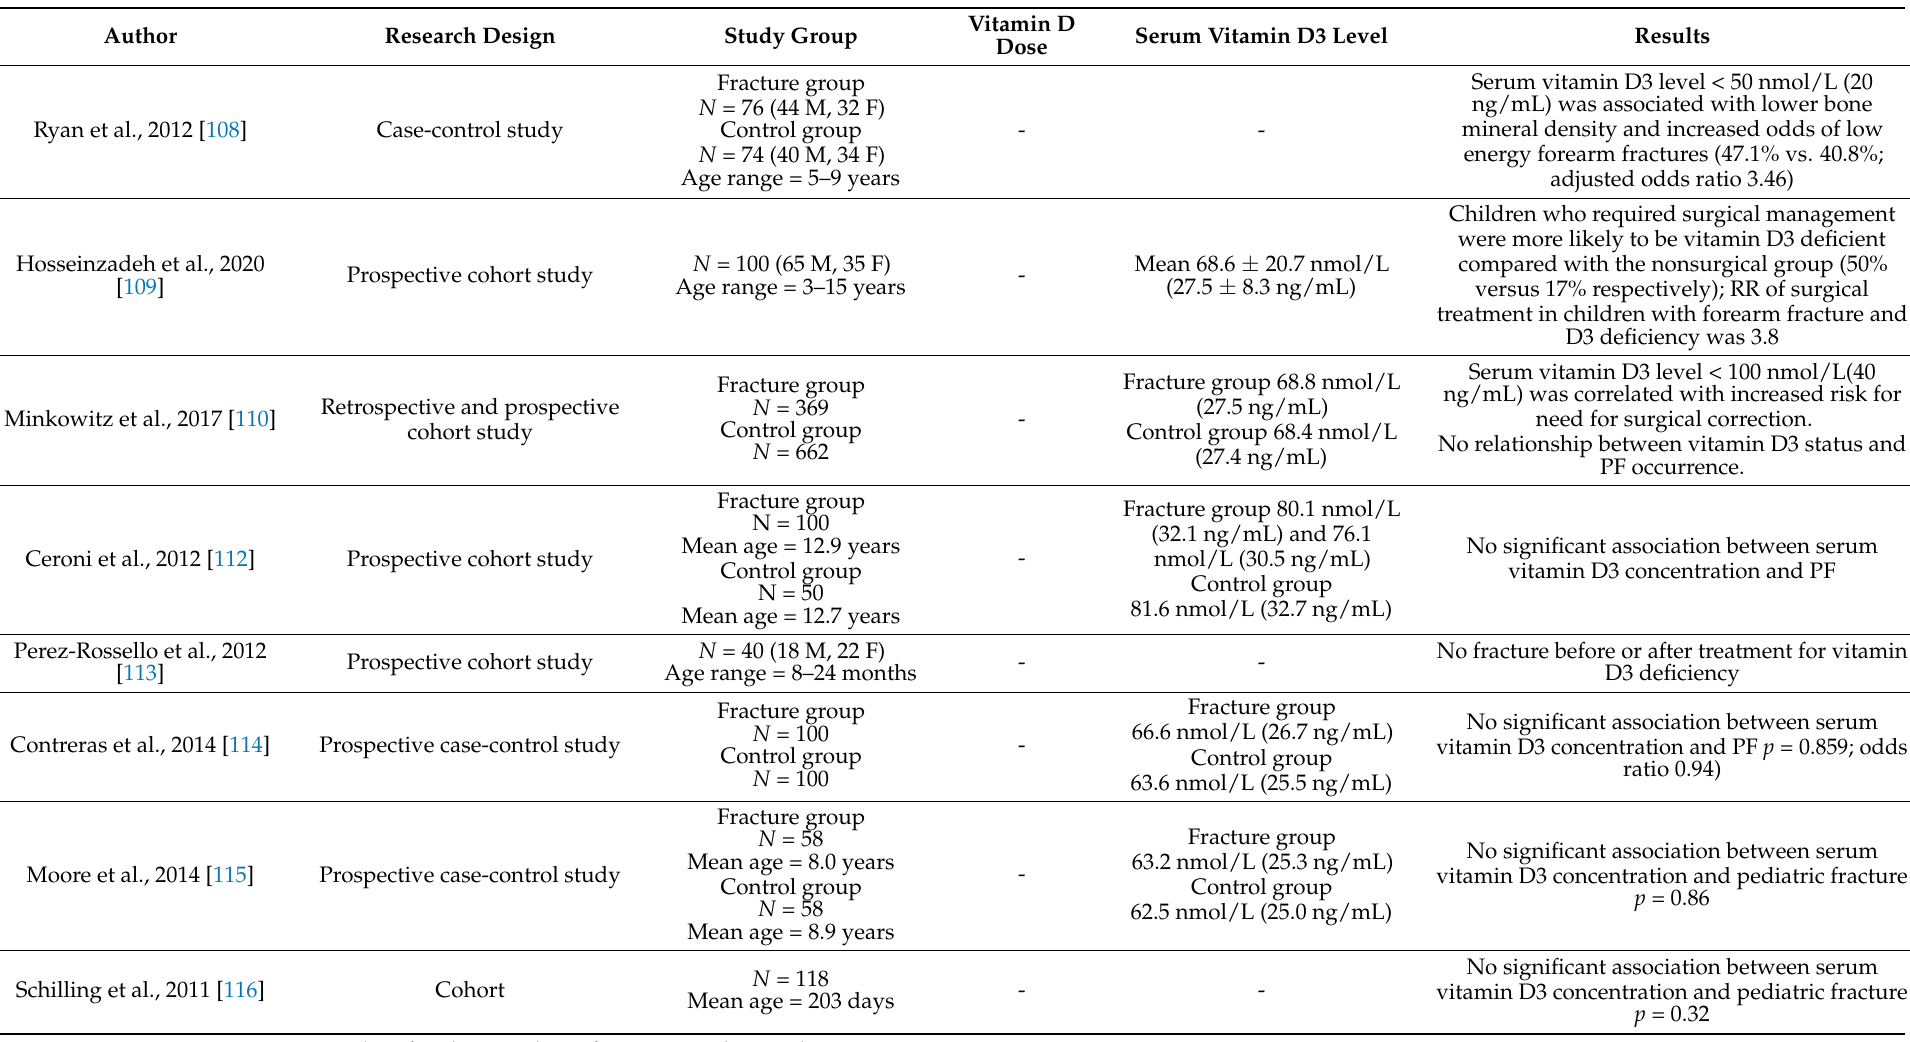
Table 5. Vitamin D supplementation and pediatric